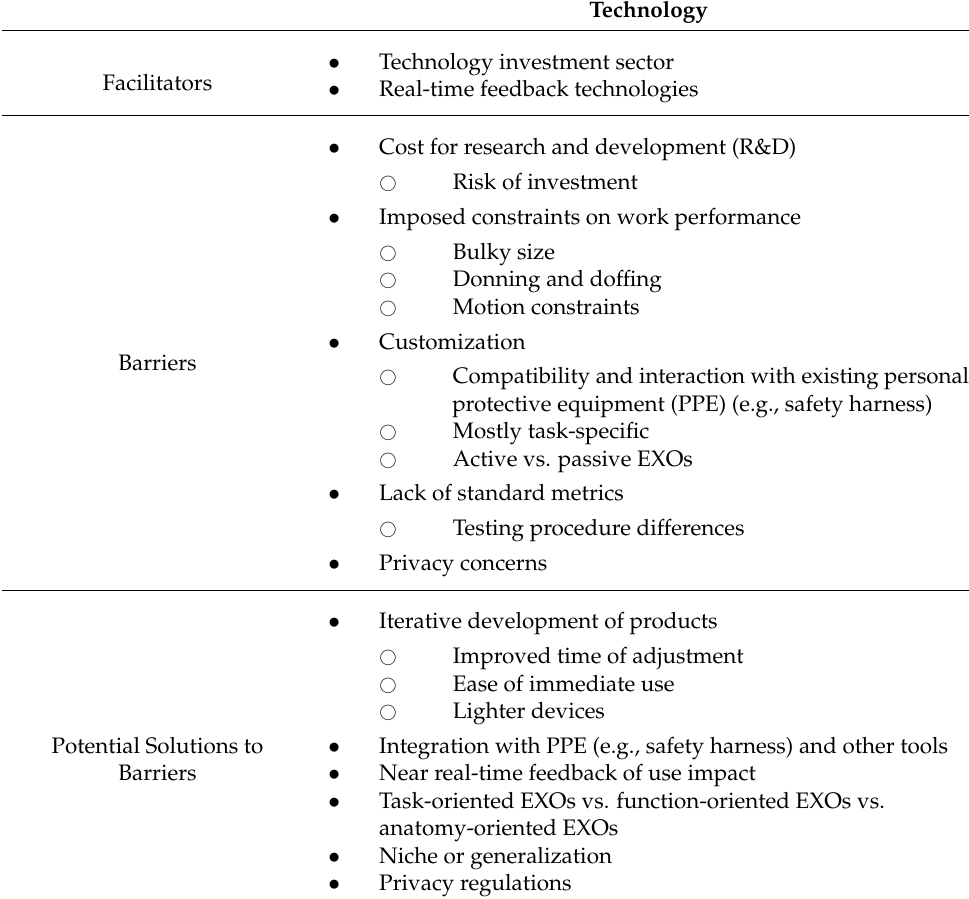
Table 4. Summary of technology category